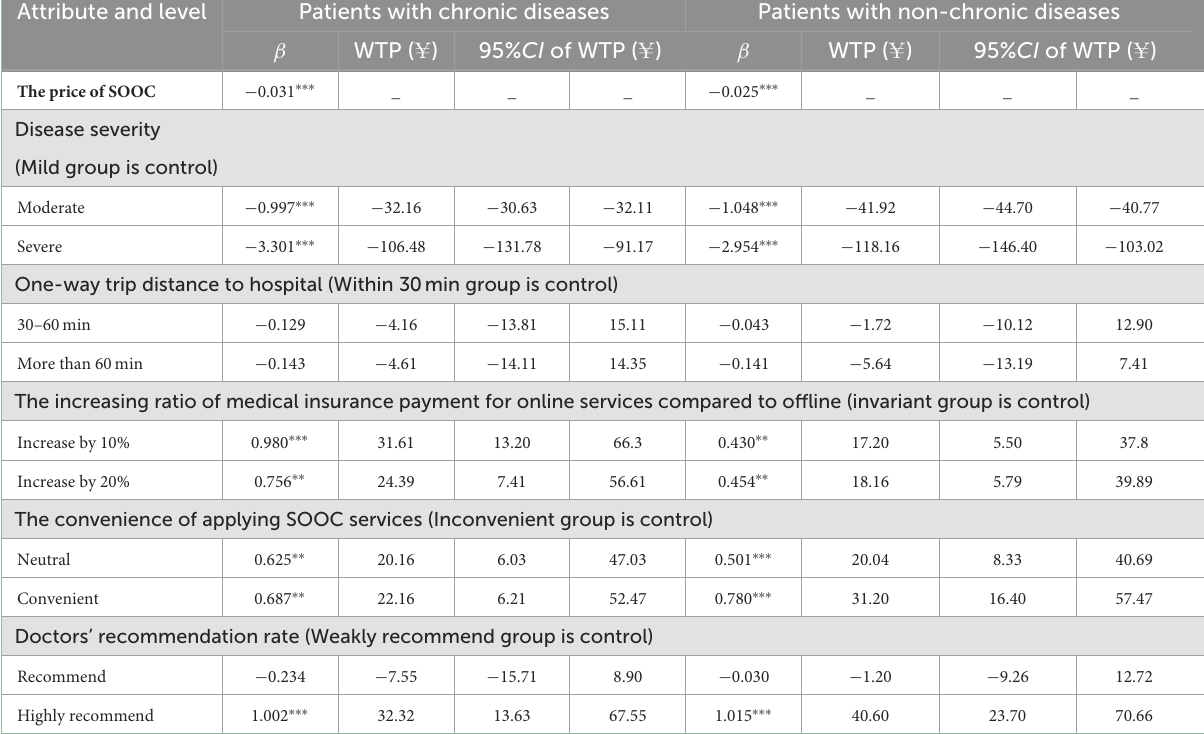
TABLE 7 Conditional logit regression analysis and the WTP based on the factor that whether the patients have chronic diseases. Attribute and